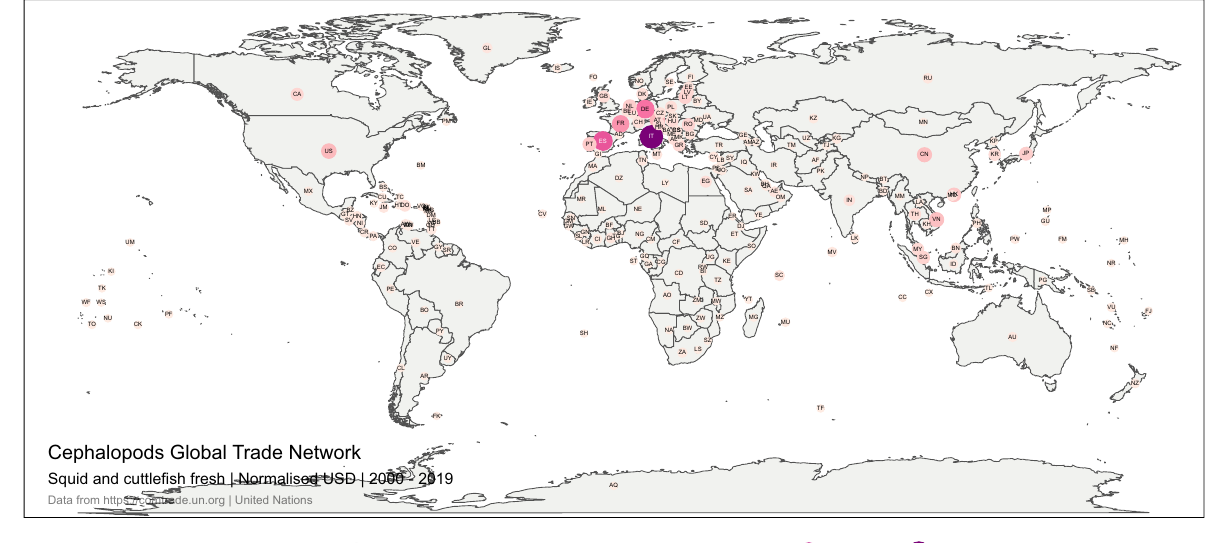
Figure 7. Global trade network for squid and cuttlefish live, fresh or chilled between 1 January 2000, and 31 December 2019 in monetary value (USD). The numbers correspond to the normalised PageRank for the monetary value. Each node represents a trader. The size and colour of the node represent the relative importance of the trader in the network in terms of its PageRank. The figure was created with R 12 (https:// cran.r- proje ct. org) packages: “ggplot2” v.3.2.1 13 (https:// ggplo t2. tidyv erse. org), “ggmap” v.3.0.0 29 (https:// github. com/